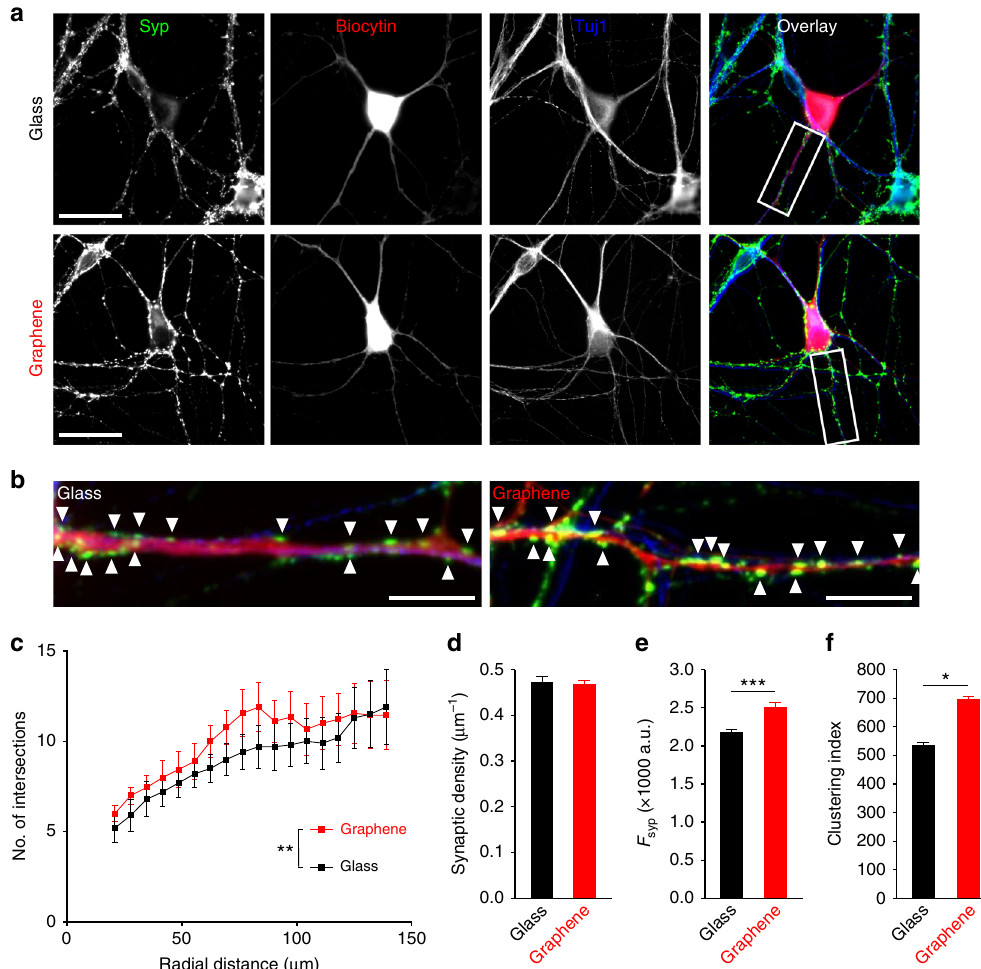
Fig. 6 Morphological comparison of neurons on glass or graphene. a Sample images of immuno fl uorescence staining for the synaptic vesicle marker, Synaptophysin (Syp, green), and neuron-speci fi c class III β -tubulin (TuJ1, blue) in recorded cells (biocytin fi lled, red). Scale bar, 30 μ m. b Inset regions from the sample images are indicated by white boxes. Scale bar, 15 μ m. Arrowheads indicate examples of Syp puncta. c Sholl analysis (** p = 0.01, F (1,323) = 6.7, two-way ANOVA with repeated measures followed by a Bonferroni multiple comparisons test, ω 2 = 0.017, n glass = 12 cells, n graphene = 11 cells, N > 4 batches). d Lateral density of Syp puncta along the neurites of recorded neurons (Tuj1-positive and biocytin-positive) ( n glass = 12 cells, n graphene = 11 cells, N > 4 batches; p > 0.1, two-tailed t -test). e Average Syp immunostaining ( n > 10,000 synapses analyzed, N > 3 batches, *** p < 0.001, two-tailed t -test, Cohen ’ s d = 0.500). f Average Syp clustering within individual synaptic boutons ( n ≥ 3 FOVs, N = 3 batches; * p < 0.05, two-tailed t -test, Cohen ’ s d = 0.65). Error bars are